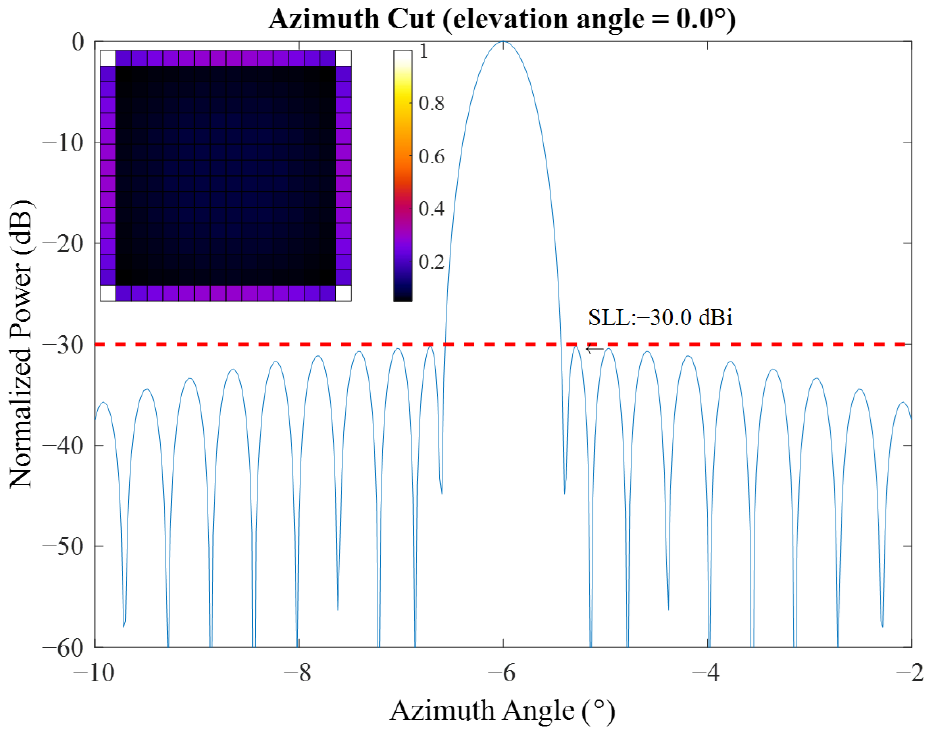
Figure 8. Azimuth cut of a 16 × 16 DRA using subarrays as radiating elements separated by 2.5 λ 0 with a Hamming window applied to the weight